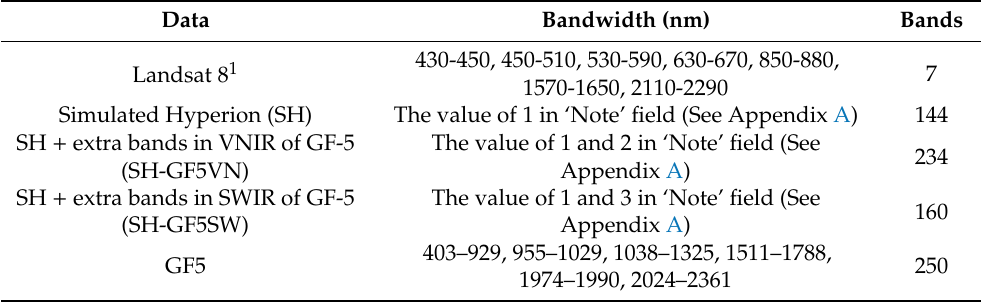
Table 4. The band number and bandwidth of five di ff erent datasets for